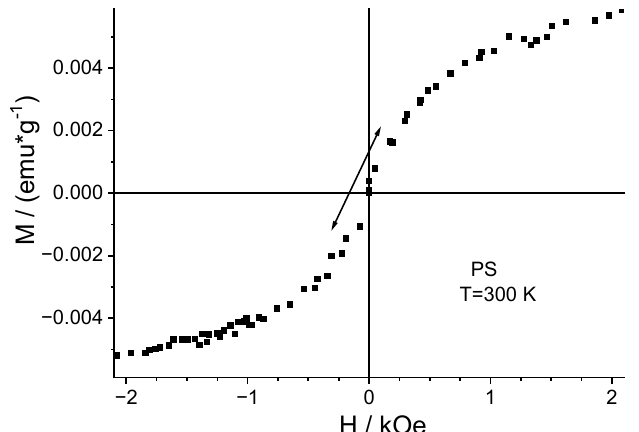
Figure 6. Magnetic field dependence of the specific magnetic moment for the PS at T = 300 K. This dependence is typical of the entire temperature range under study.